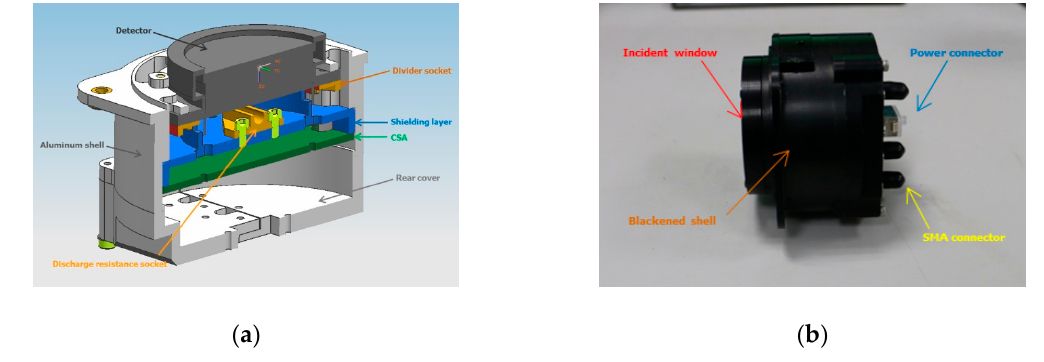
Figure 2. ( a ) Profile of an FUV imaging detector module. It is composed of an MCP detector with a wedge strip anode, a high-voltage divider, and three charge-sensitive spectroscopy amplifiers. ( b ) Photograph of an FUV imaging detector. The aluminum shell was anodized in black to satisfy the requirements of thermal control. Three-channel pulse signals from CSAs travel down pulse shapers through the SMA connectors.